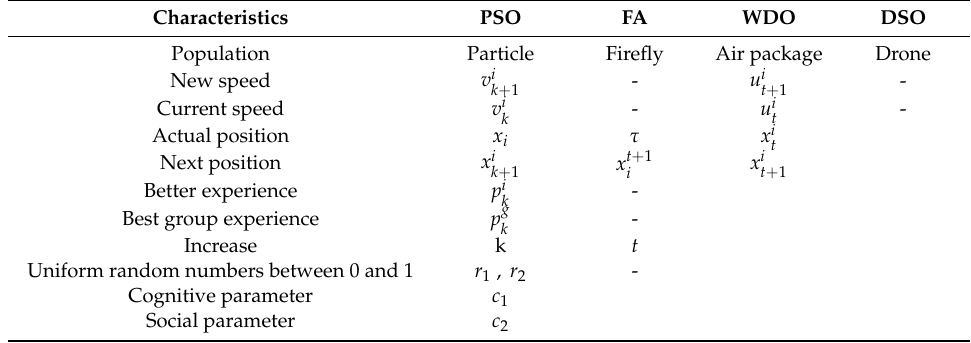
Uniform random numbers between 0 and